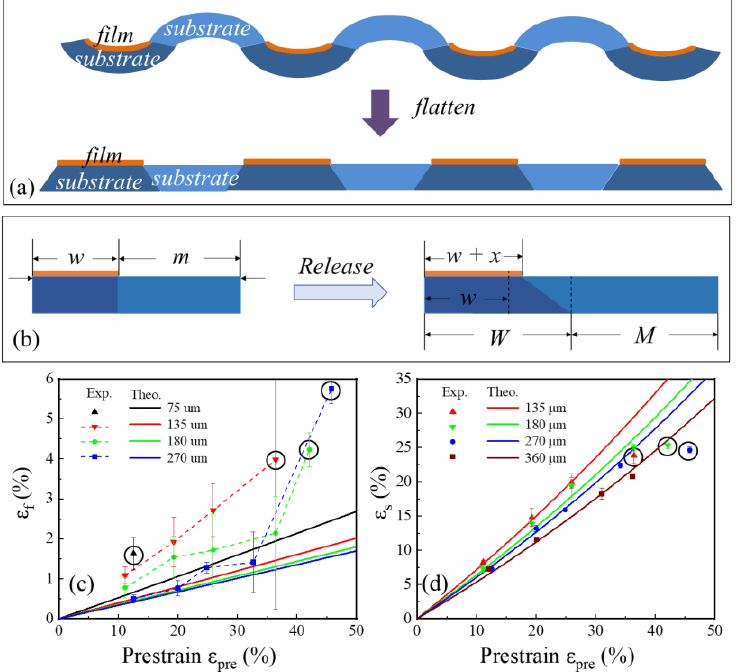
Figure 6. Ta (2.5 nm)/CoFeB (20 nm)/Ta (2.5 nm) film. ( a ) The cross-section of the prestrain strip film. ( b ) Analysis of single strip film. ( c ) Strain of 100 µ m strip films with different spacing under different prestrains. ( d ) Strain of blank substrates with different widths under different prestrains. The lines are the theoretical values and the points are the experimental values. Table 1. Comparison of experimental and theoretical values of transverse strain of blank strip substrate in Figure